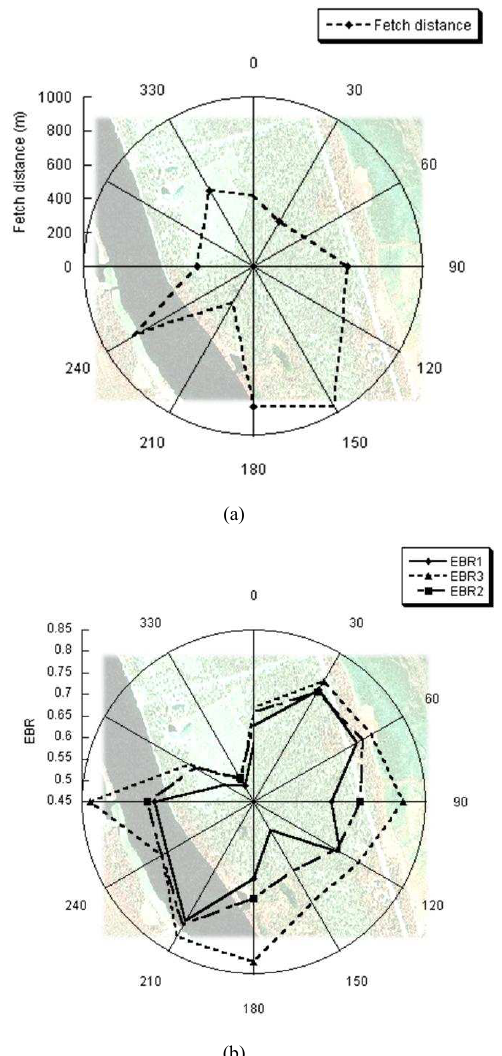
Fig. 5. Combination of an aerial view of the study site with a po- lar plot, centred on the location of the meteorological tower, show- ing the effect of the wind direction on: (a) the fetch distance, (b) the energy balance ratio. Values indicate averages in each angular range.